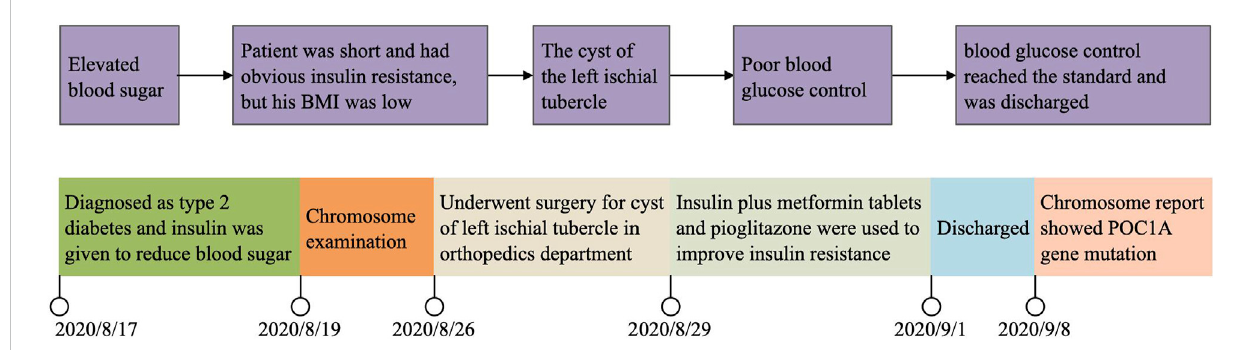
FIGURE 2 Showcasing a timeline with relevant data from the episode of care.